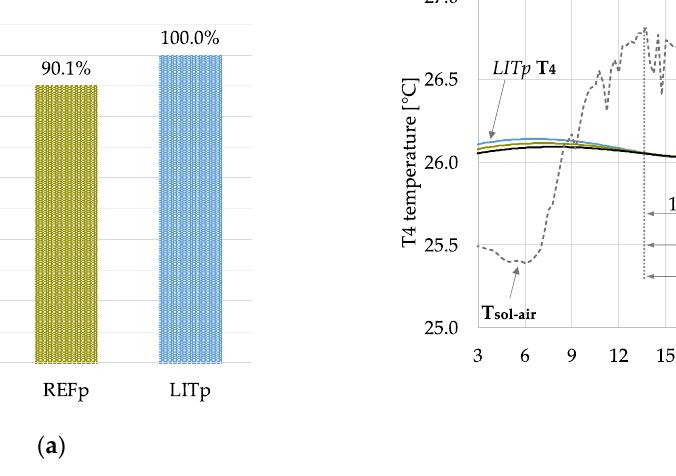
Figure 13. ( a ) Percentage comparison between the incoming energies in the case of the three-brick- thick wall; ( b ) detail of the temperature on the inner side of the wall for the same day as Figure 9 and relative delay from T sol-air peak temperature for the three-brick-thick wall.